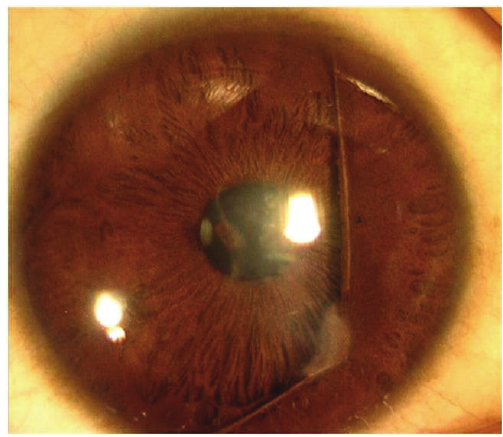
Figure 1: Slit-lamp photograph of eye showing anterior segment dysgenesis.